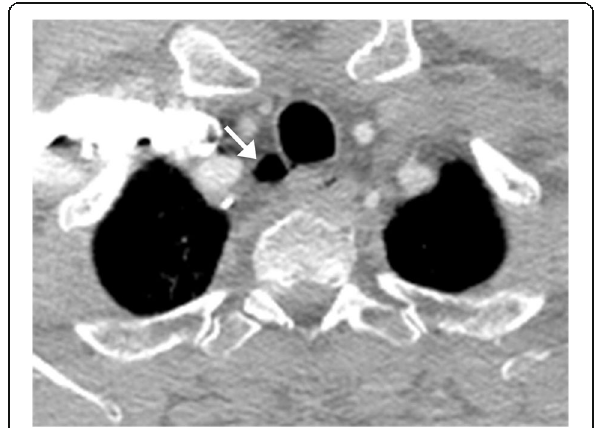
Fig. 15 Tracheal diverticulum. Axial CT image demonstrates a focal outpouching (arrow) of the posterior right tracheal wall containing gas, consistent with a tracheal